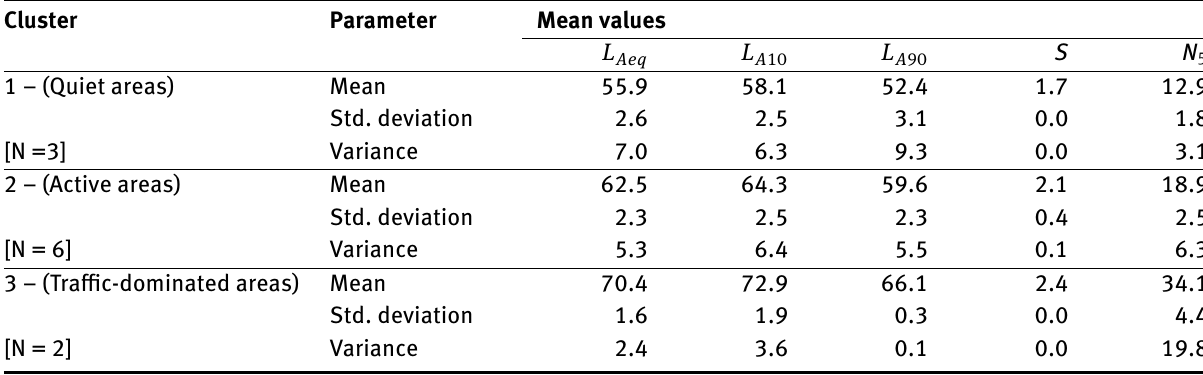
Table 2: Descriptive statistic of the psychoacoustic metrics for the three identified clusters Cluster